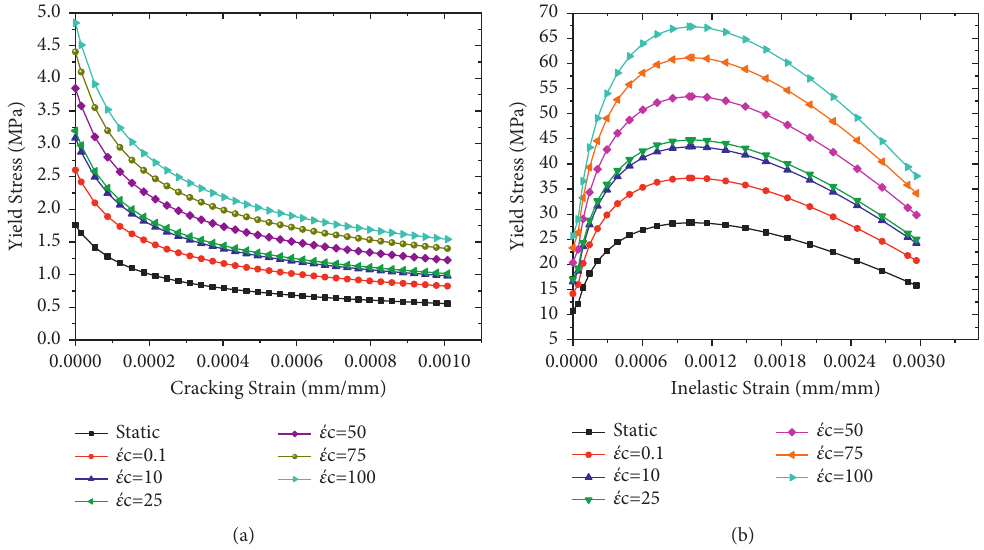
Figure 9: Strain rate effect on concrete material: (a) tensile strength; (b) compression strength.